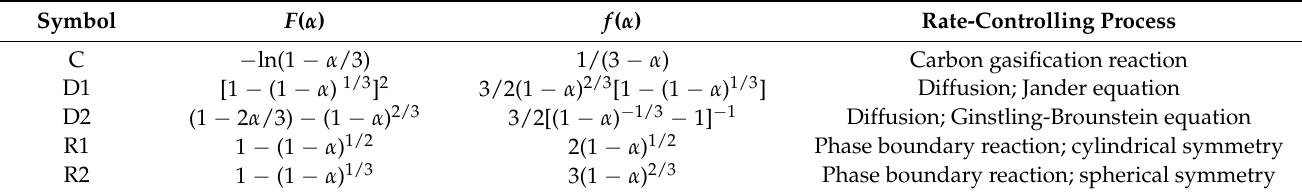
Table 3. Mechanism functions of the reduction process.